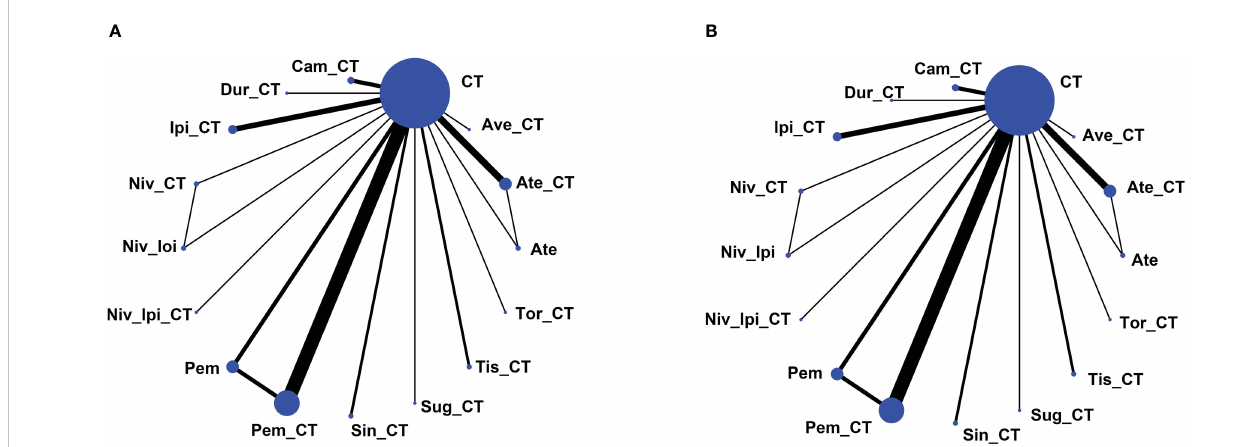
FIGURE 2 Network map of comparisons based on 16 therapeutic regimens for adverse events of any grade (A) or adverse events of grade 3 or higher (B) . Treatment types are represented by circular nodes, and node size is proportional to the number of patients administered a given treatment. Lines represent head-to-head comparisons, and line width is proportional to the total number of studies comparing the connected treatments. Ate, Atezolizumab; CT, Chemotherapy; Ate_CT, Atezolizumab + chemotherapy; Ave_CT, Avelumab + chemotherapy; Cam_CT, Camrelizumab + chemotherapy; Dur_CT, Durvalumab + chemotherapy; Ipi_CT, Ipilimumab + chemotherapy; Niv_CT, Nivolumab + chemotherapy; Niv_Ipi, Nivolumab + Ipilimumab; Niv_Ipi_CT, Nivolumab + Ipilimumab + chemotherapy; Pem, Pembrolizumab; Pem_CT, Pembrolizumab + chemotherapy; Sin_CT, Sintilimab